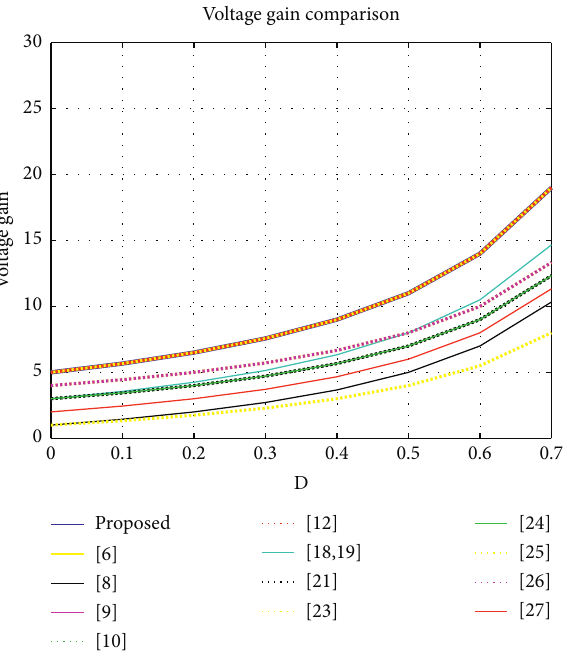
Figure 9: Voltage gain comparison curve of the converters.